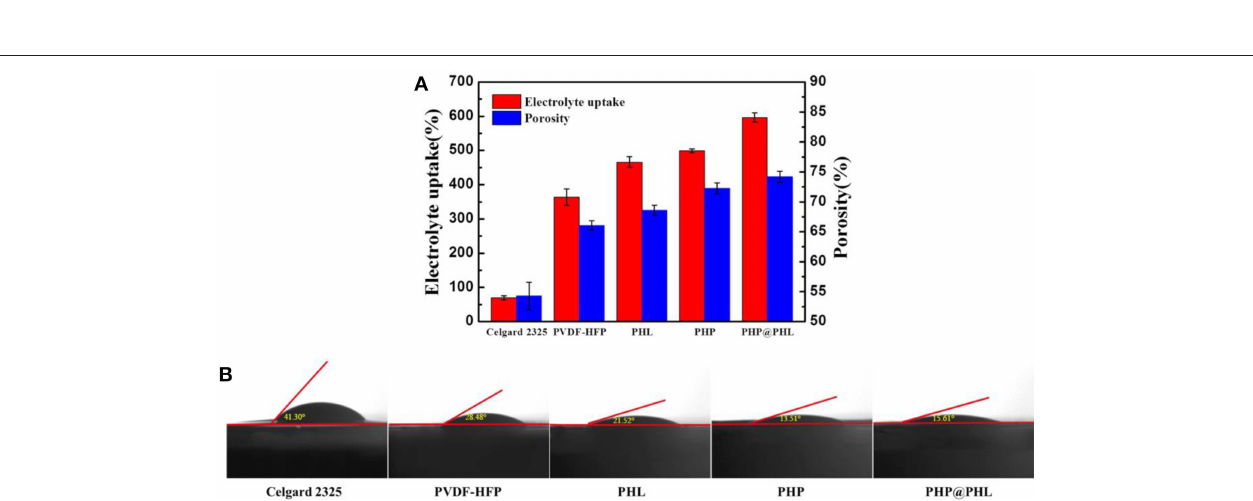
Frontiers in Chemistry | www.frontiersin.org